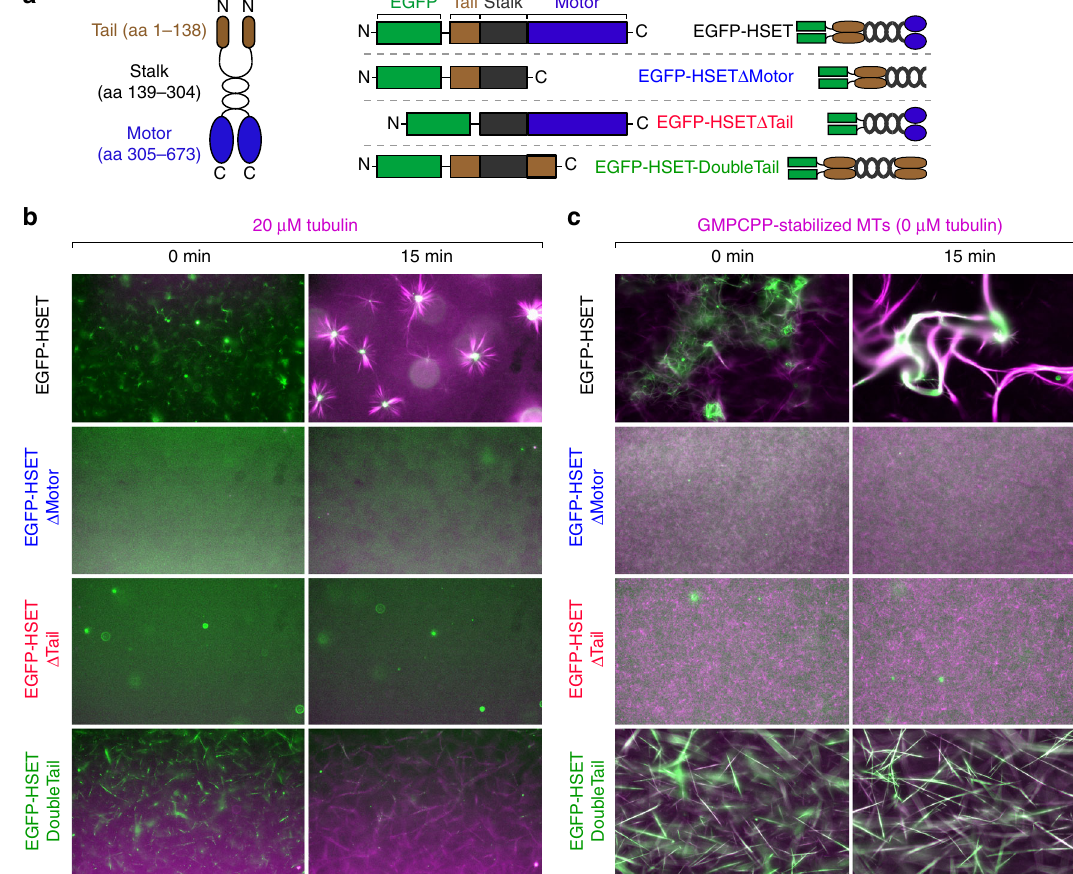
Fig. 1 Full-length HSET organizes growing MTs into asters. a Schematic of HSET truncations puri fi ed in this study. HSET contains two MT-binding domains: an ATP-independent globular tail domain located at the N terminus (amino acid 1 – 138, brown), and an ATP-dependent conserved kinesin motor domain located at the C terminus (aa 305 – 673, blue). HSET also contains a coiled-coil stalk domain necessary for dimerization (aa 139 – 304, black). All constructs contained an N-terminal 6× His tag used for af fi nity puri fi cation. b Aster formation of growing MTs by HSET. 20 µ M tubulin (10% Alexa594-labeled, magenta) was mixed in assay buffer with the indicated EGFP-HSET truncation (green) and monitored by time-lapse microscopy at 37 °C. With the exception of EGFP-HSET Δ Tail (20 nM), all HSET constructs were present at 100 nM. c Bundle formation of nongrowing, GMPCPP-stabilized MTs by HSET. Alexa594-labeled GMPCPP-MTs (10% labeled, 1 µ M tubulin in polymer form, magenta) were mixed in assay buffer with the indicated EGFP-HSET truncation (green) and monitored by time-lapse microscopy at 37 °C. HSET concentrations are identical to b . For contrast measurements over time, see Supplementary Figure 1d, e. For movies, see Supplementary Movies 1 – 2. For additional EGFP-HSET images on GMPCPP-MTs, see Fig. 4a. Technical replicates of experiments in b , c were repeated n ≥ 3 times for each condition, and representative images are shown. Scale bars, 50 µ